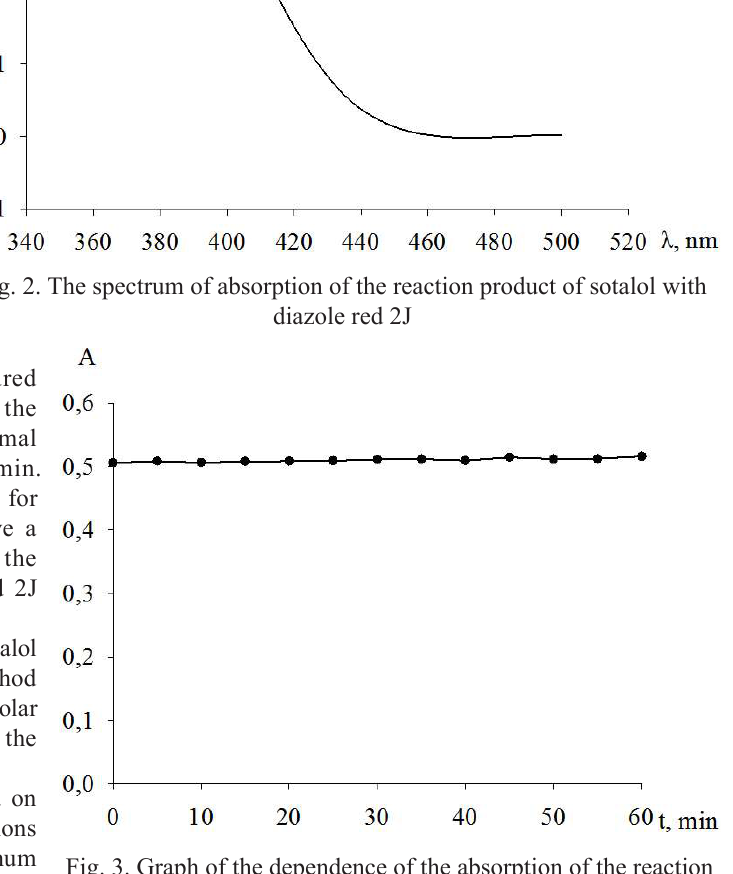
Fig. 3. Graph of the dependence of the absorption of the reaction product of sotalol with diazole red 2J in aqueous methanol solution depending on